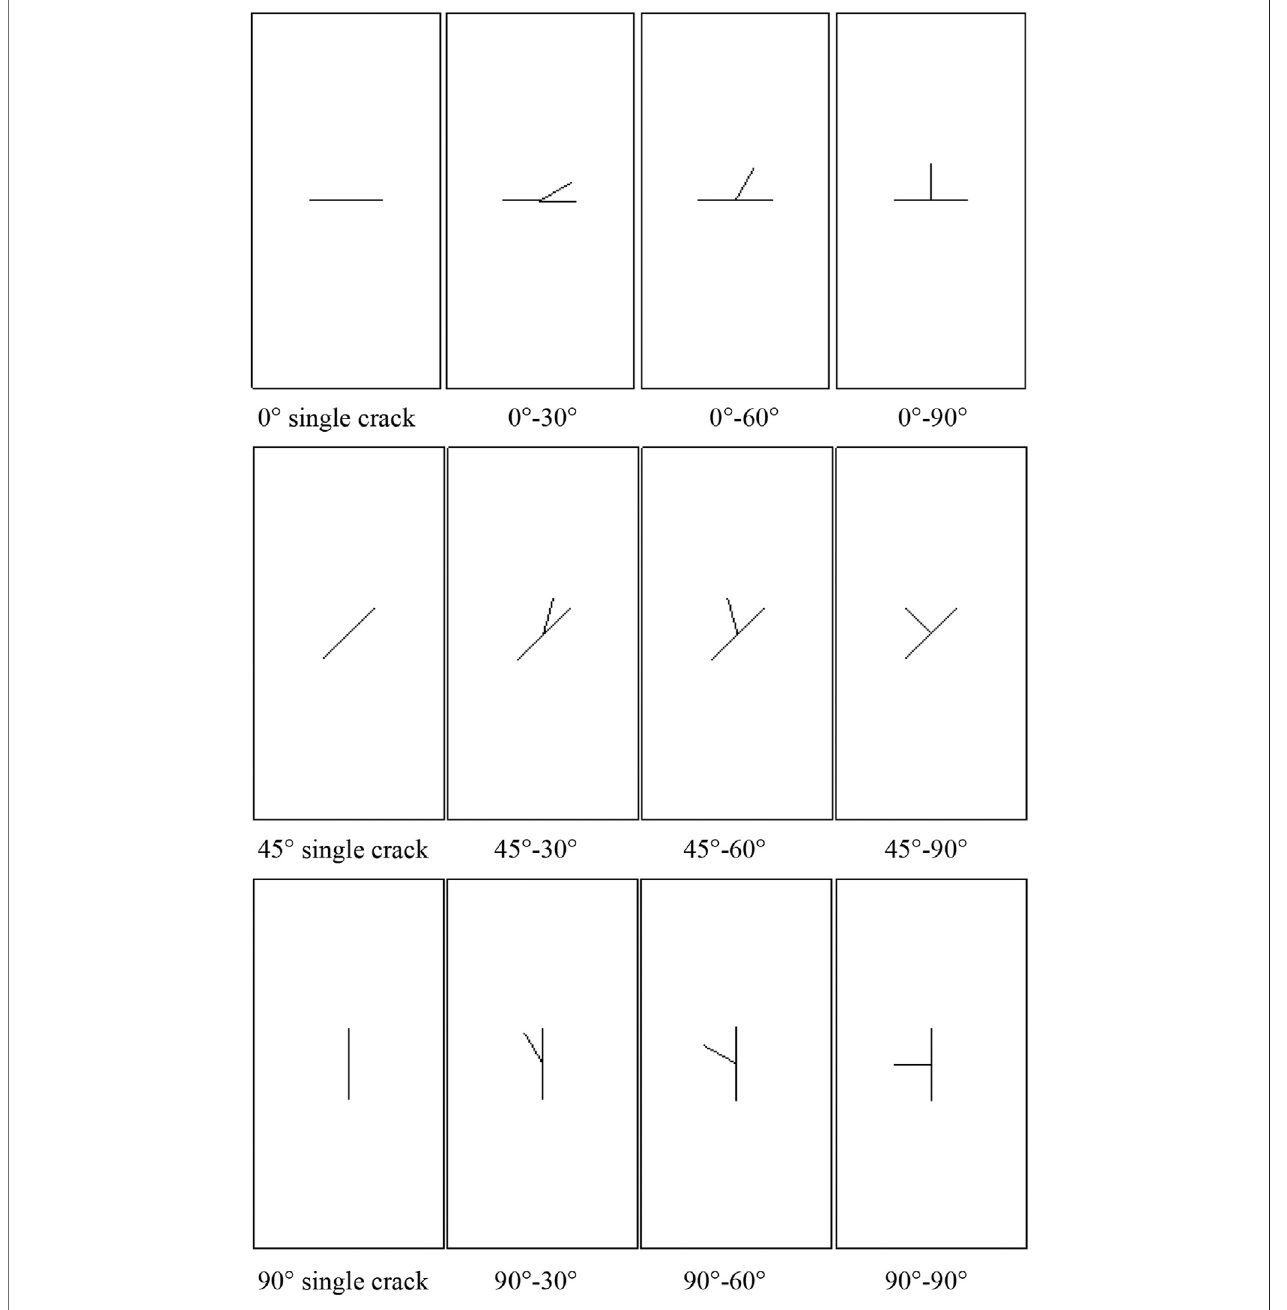
FIGURE 3 | Schematic diagram of the crack samples produced by the